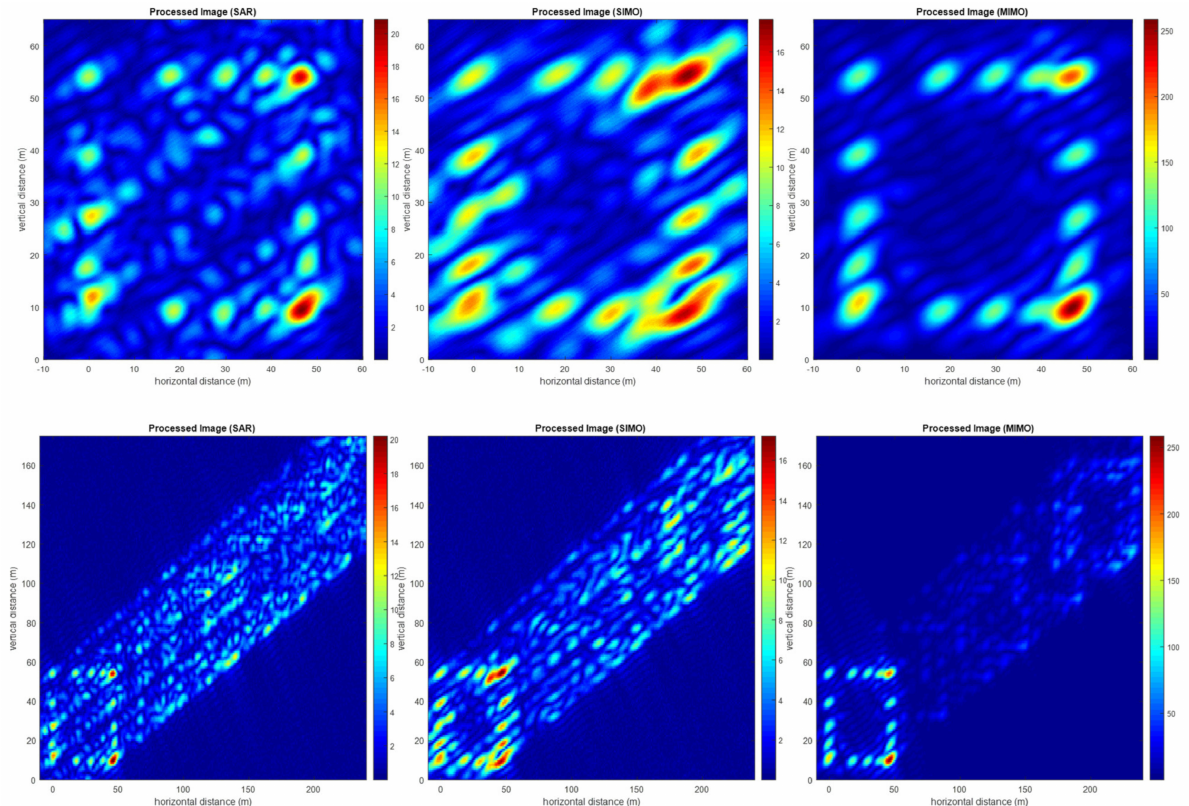
Figure 34. The simulated 2D images for Example 9 for SAR/SIMO/MIMO modes. Upper row: fine scene resolution (20 cm), small scene extent. Lower row: coarse scene resolution (1 m), large scene